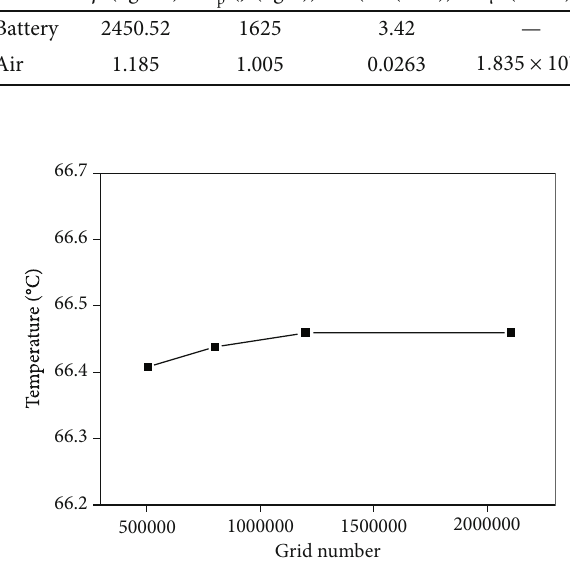
Figure 4: Independence test of the grid number.